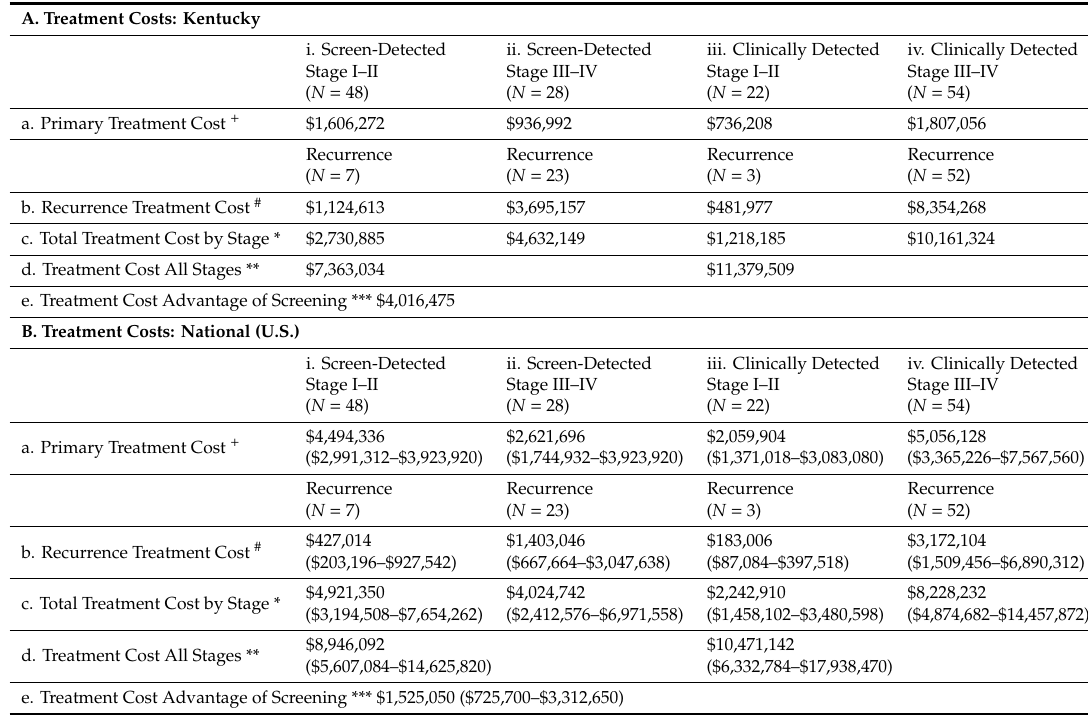
Table 2. Estimated cost of treating screen-detected and clinically detected ovarian cancer using the Kentucky cost estimates (A) and the national cost estimates